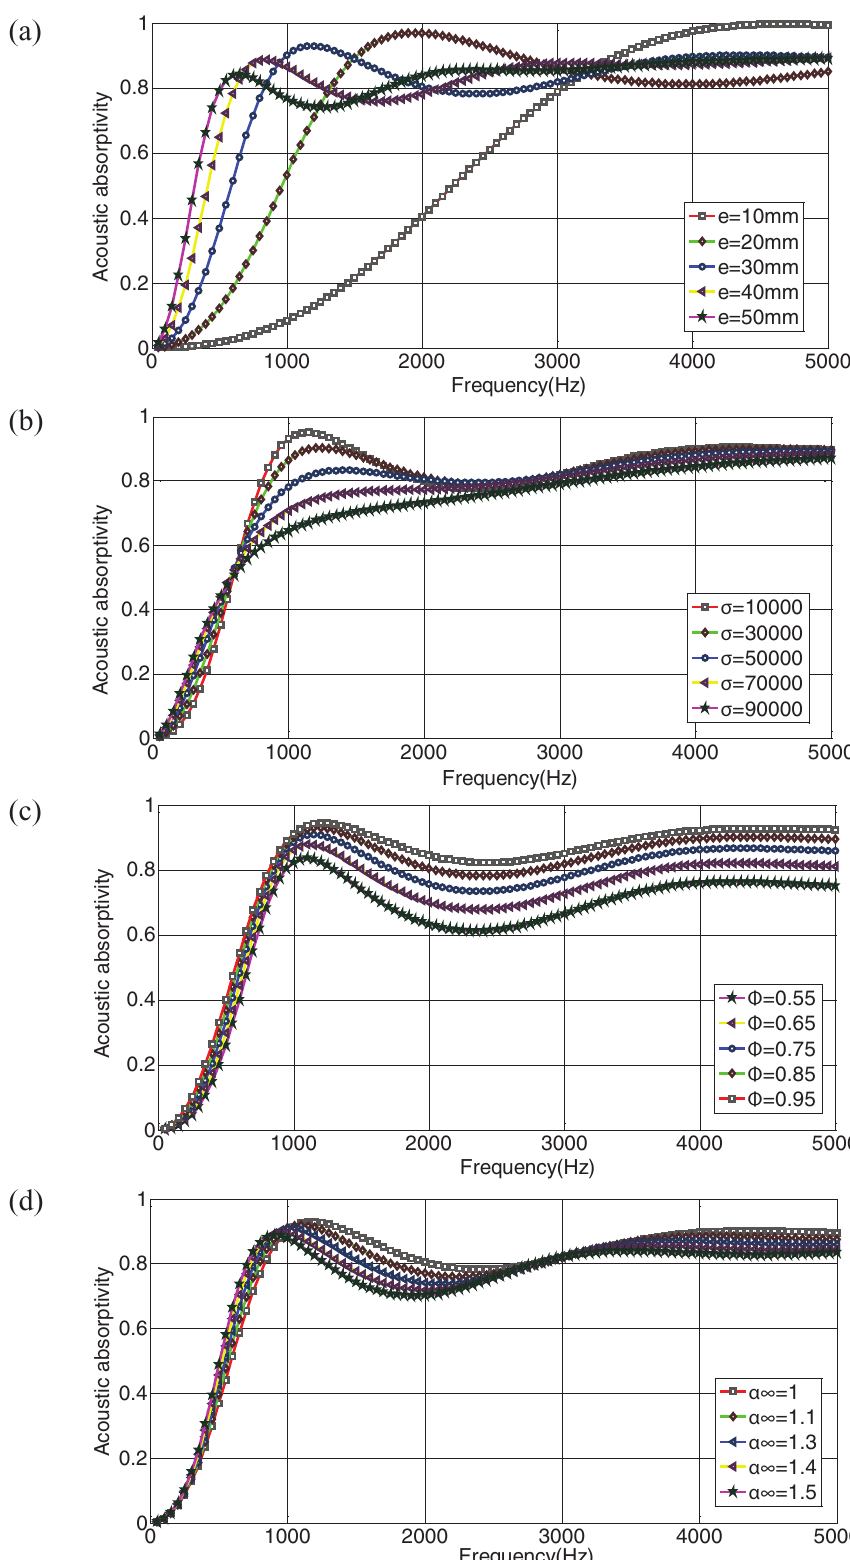
Figure 1: Influence of various parameters on sound absorption coefficient of PM: (a) thickness e , (b) flow resistance s , (c) porosity Φ , (d) curvature α ∞